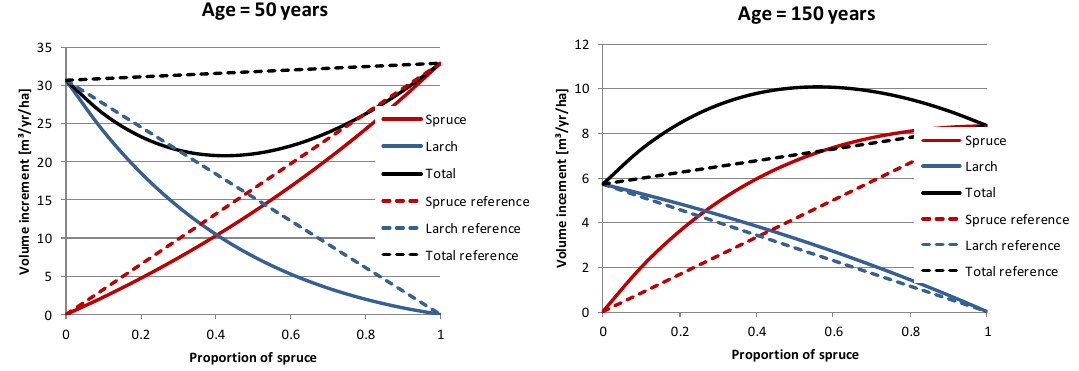
Figure 5. The Kelty diagrams as they result from Equation (6), with coefficients from Table 6.